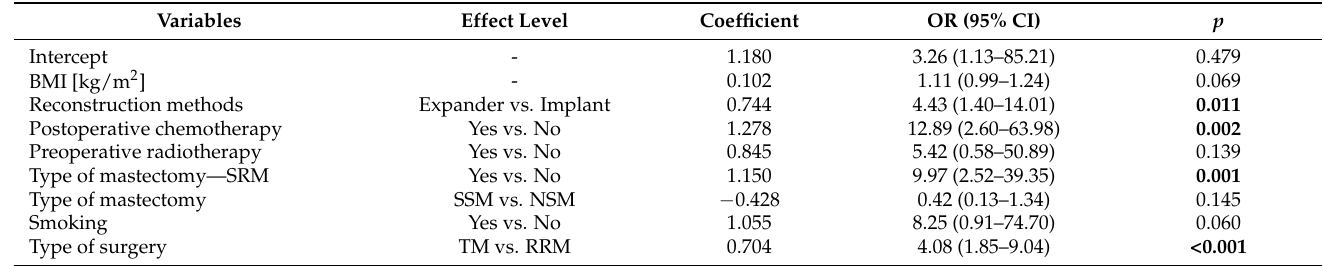
Table 6. Multivariate logistic stepwise backward regression of factors potentially associated with achievement of the composite endpoint (minor and major complications after breast reconstructions including presence of